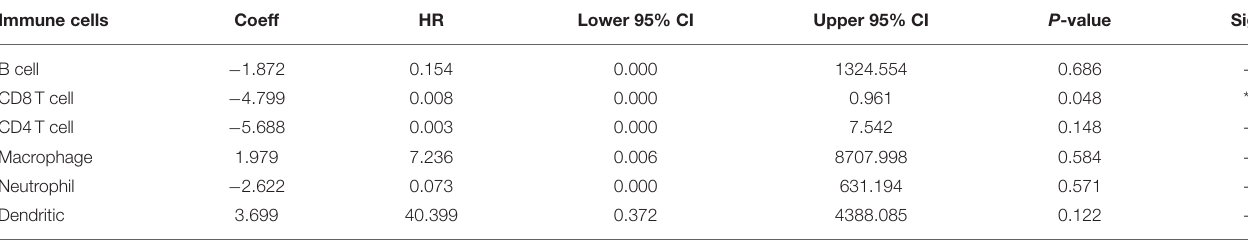
TABLE 1 | Multivariate Cox regression analysis of immune infiltration cells in cervical squamous cell carcinoma (CESC). Immune cells Coeff HR Lower 95% CI